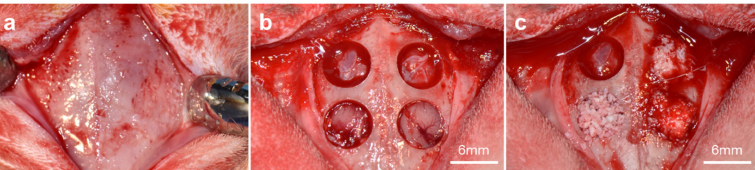
Figure 2. Surgical procedures using a critical-sized calvaria bone defect model in rabbit. ( a ) Exposed rabbit calvarium, ( b ) created four circular defects with a trephine bur, and ( c ) implanted bone materials into the defect area (one defect area assigned as a control group).